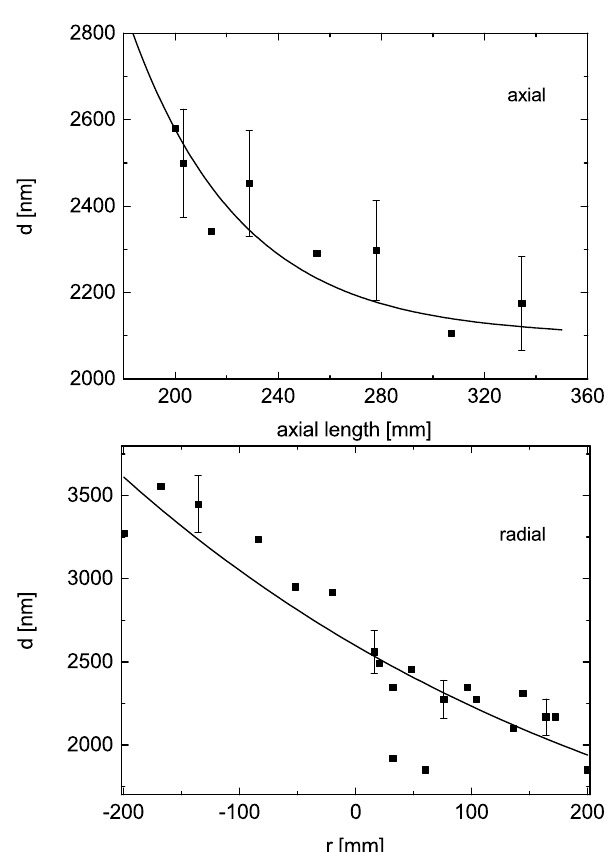
Figure 7. Axial and radial distribution of layer thickness in the CVD reactor, the radial measurement in the middle of the axis. Area load: < 1% of the inner reactor area. Clearly visible is the influence of the gas feed at the left (negative values of the radius). At the top, the deposition rate is higher than at the bottom. Fits with an erfc